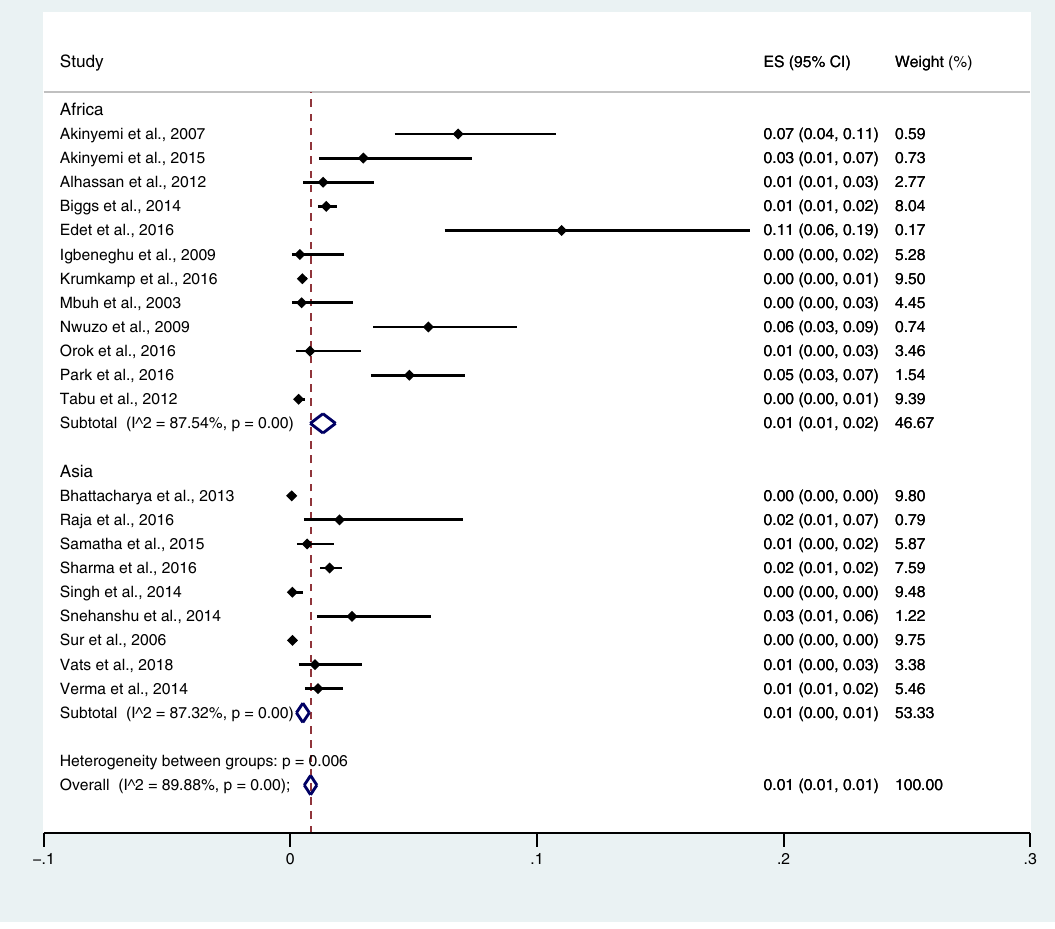
Figure 8. Pooled prevalence of typhoidal/NTS and malaria co-infection using blood cultures for the identification of Salmonella spp. infection stratified by regions. ES proportion estimate (multiply 100 units for interpreted as prevalence estimate), CI confidence interval, NS not